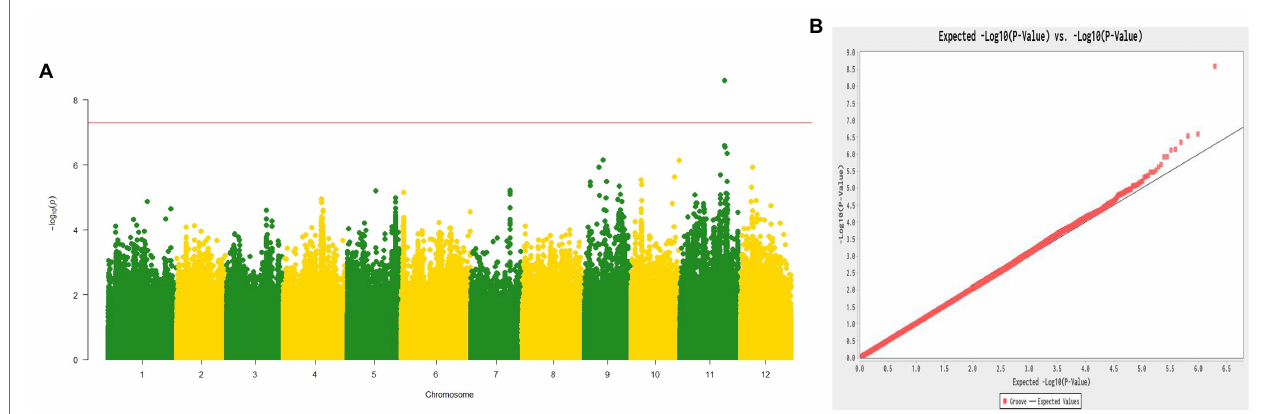
FIGURE 3 | Manhattan plot (A) and Q-Q plot (B) of the melon fsg trait through a genome-wide association study.